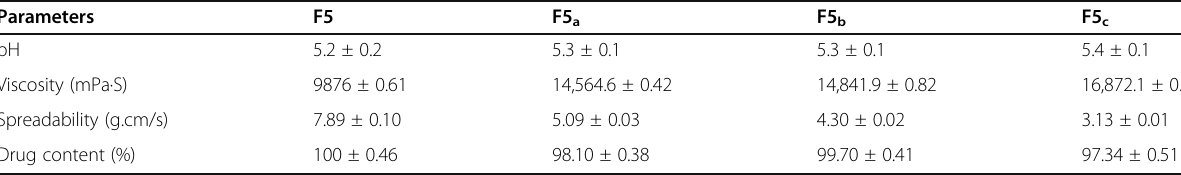
Table 4 The pH, viscosity, and spreadability of nanoemulgel formulations (% w/w)